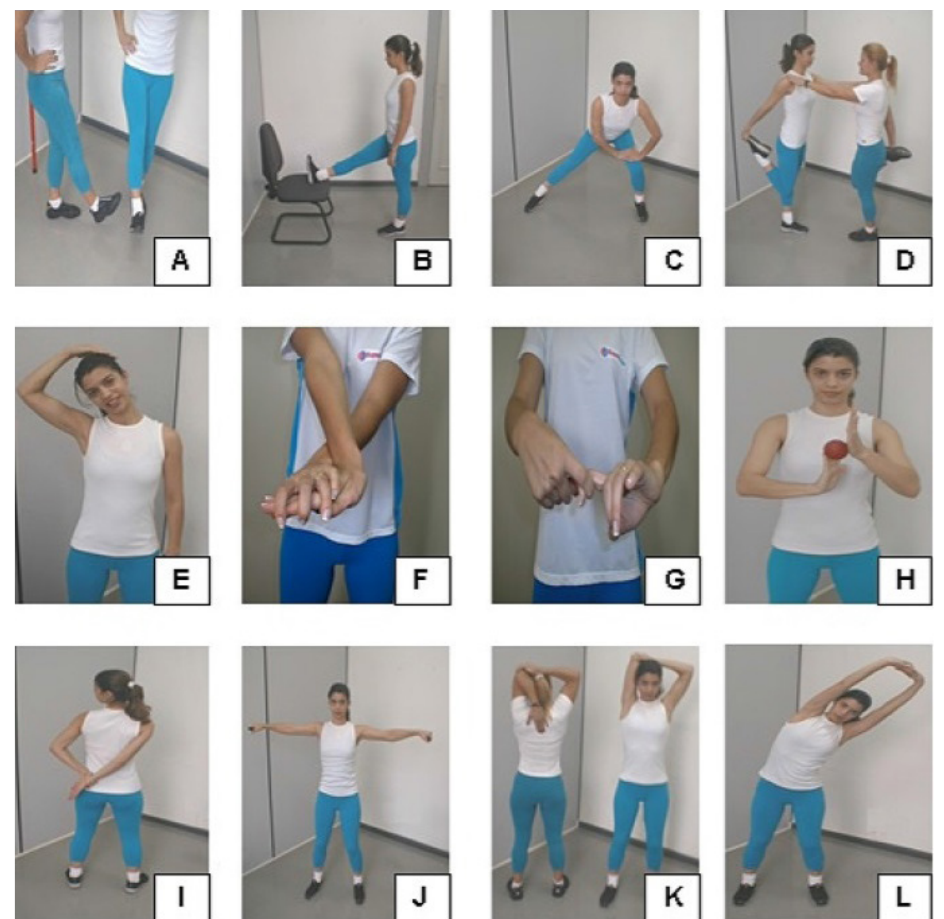
Figure 1. Representative exercises of SBP in AW and SW: ankle (A), hip and knee (B), hip, trunk and knee (C), knee (D), neck/cervical (E), wrist and forearm (F), fingers (G), wrist and hands (H), shoulder and neck (I), shoulder (J), shoulder and elbow (K) and trunk and shoulder